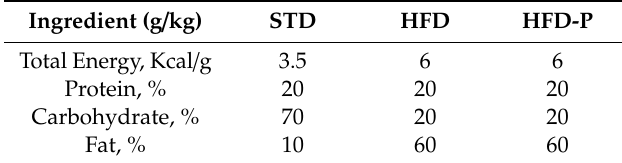
Table 2. Composition and energy densities of the STD, HFD, and HFD-P groups. Ingredient (g / kg) STD HFD HFD-P Total Energy, Kcal / g 3.5 6 6 Protein, % 20 20 Carbohydrate, % 70 20 Fat, %